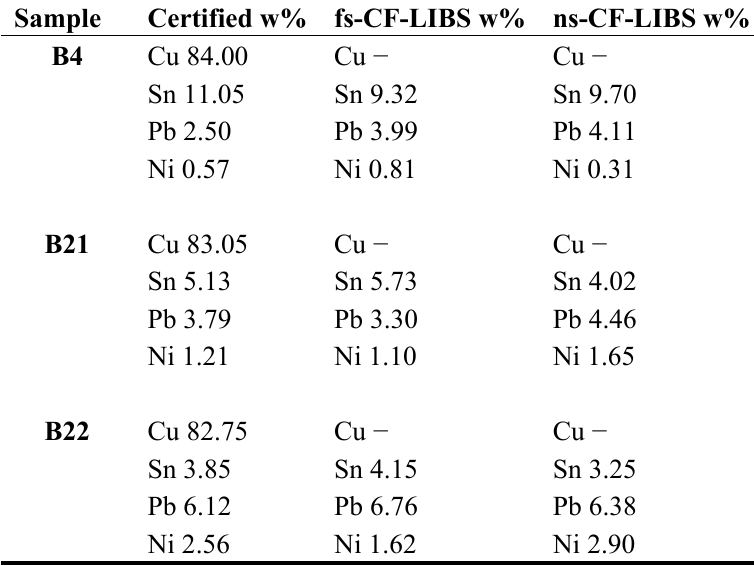
Table 1. Comparison between the CF-LIBS results for three bronze standards upon irradiation by ns- and fs-lasers. The experimental uncertainty was estimated to range between